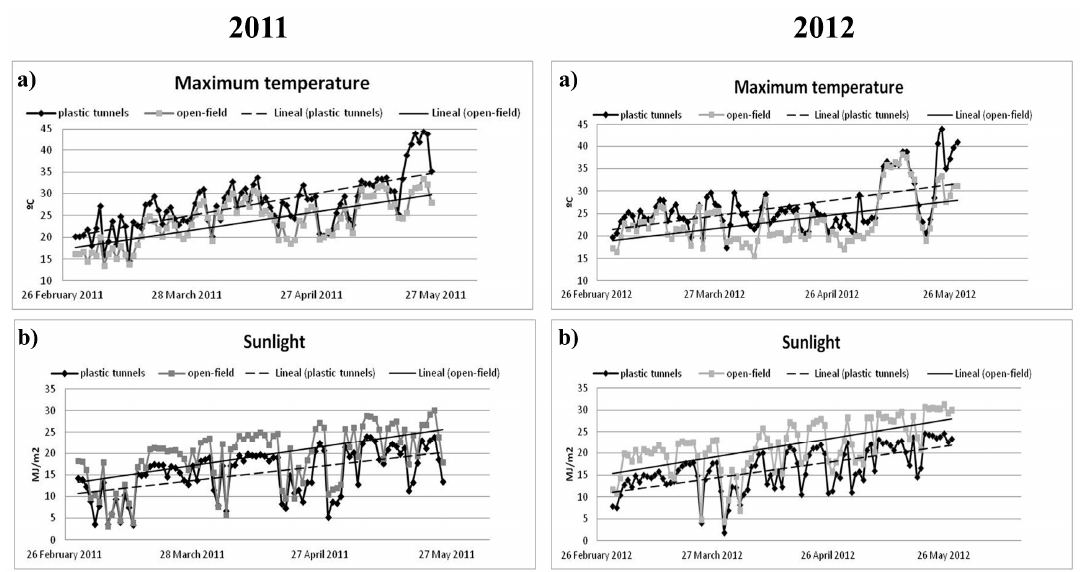
Figure 1. Maximum temperature ( a ) and sunlight ( b ) recorded in plastic tunnels and open field in 2011 ( left ) and 2012 ( right ) years.